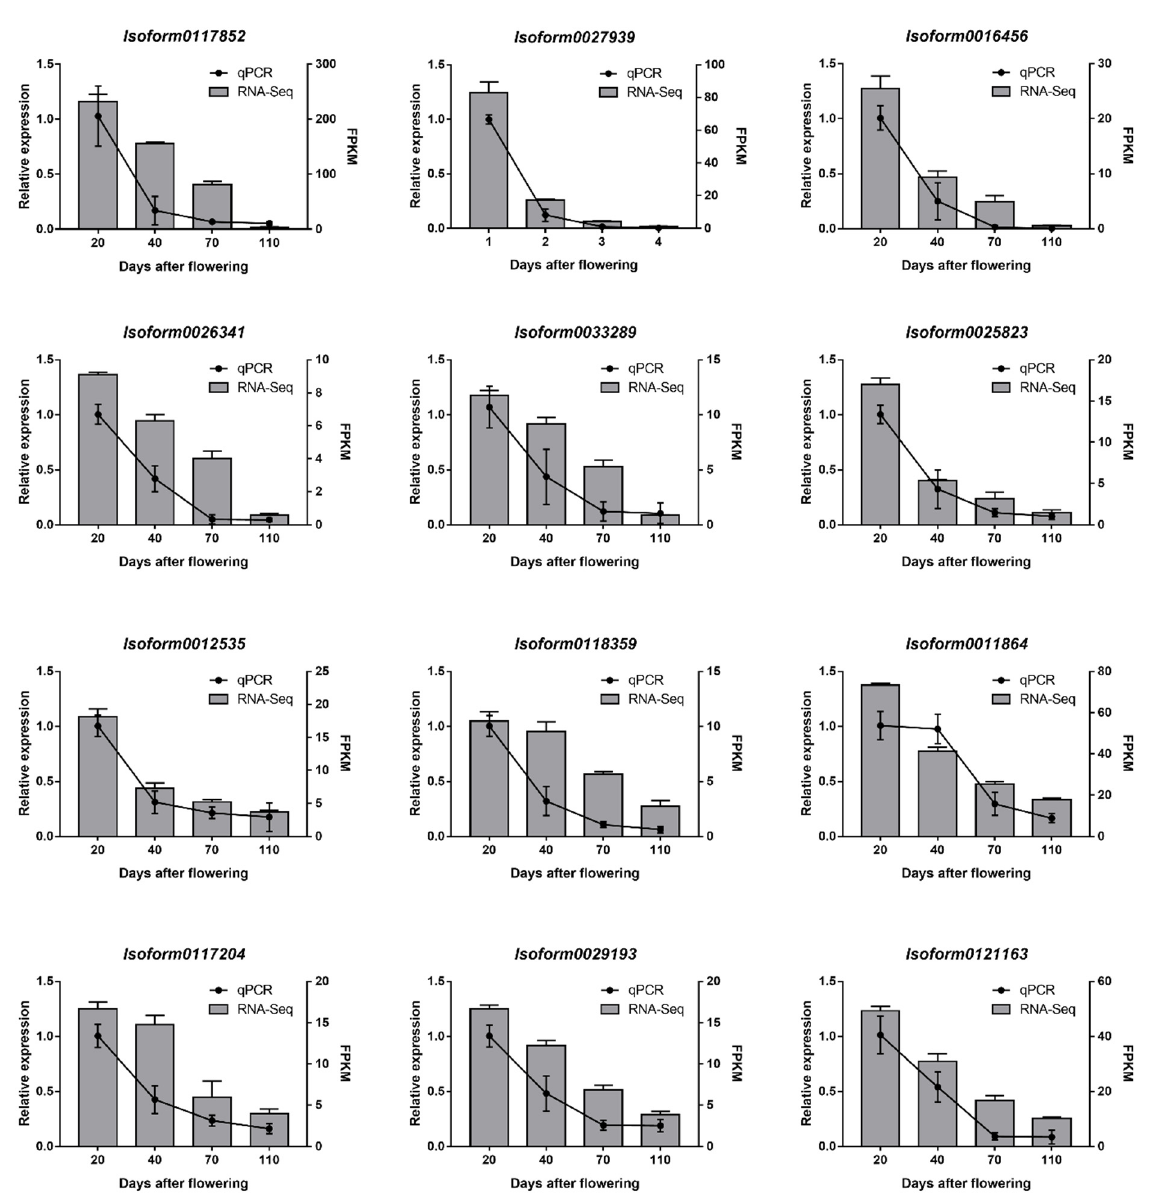
Figure 5. The relative expression of the CaUGTs in the developmental stages of C. album fruits. Relative expression of 12 genes was examined by the RT-qPCR and normalized with the reference gene ACT7 . Each reaction was performed in three biological replicates with three technical replicates. Data are means ± SD. Error bars represent standard deviations.